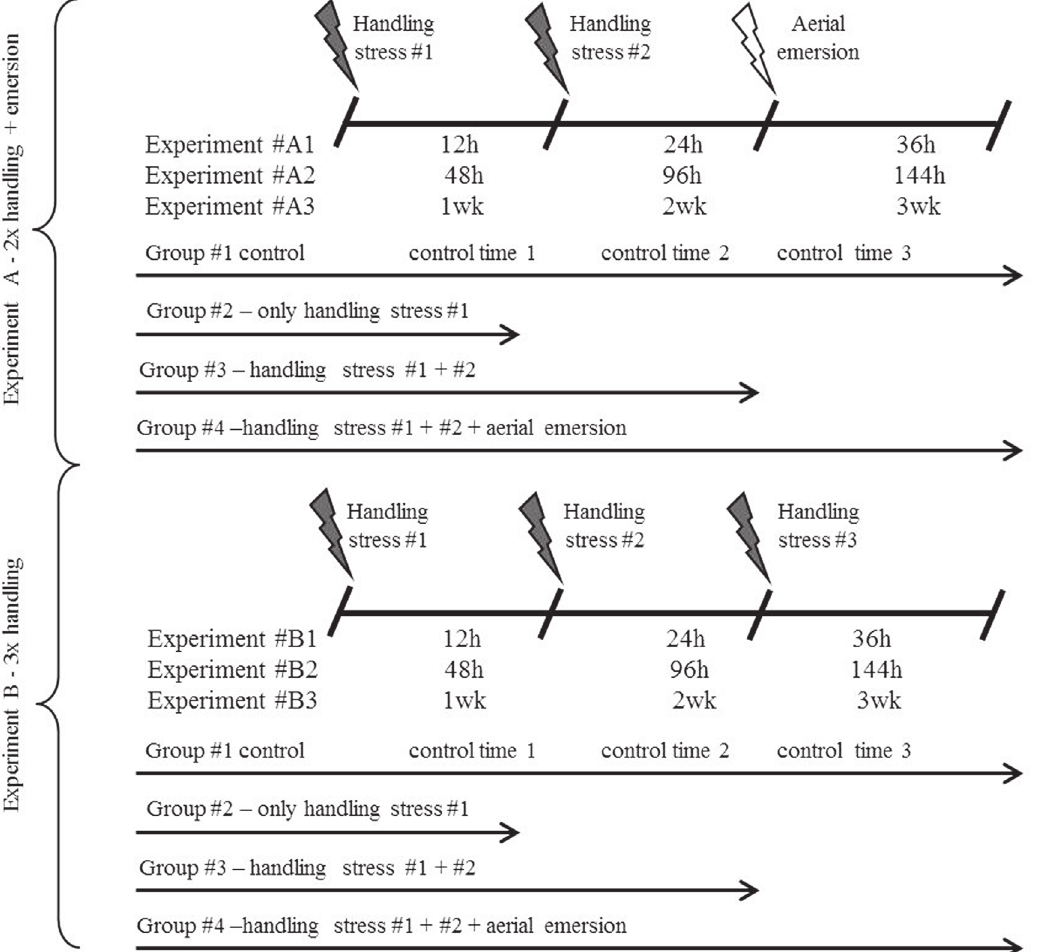
Fig. 1. Schematic representation of the experimental design of both groups of experiments. In experiment “A,” Rhamdia quelen (Quoy & Gaimard) fingerlings were sequentially exposed to the same stressors twice and to a different stress the third time. In experiment “B,” R . quelen fingerlings were sequentially exposed as the same stressors 3